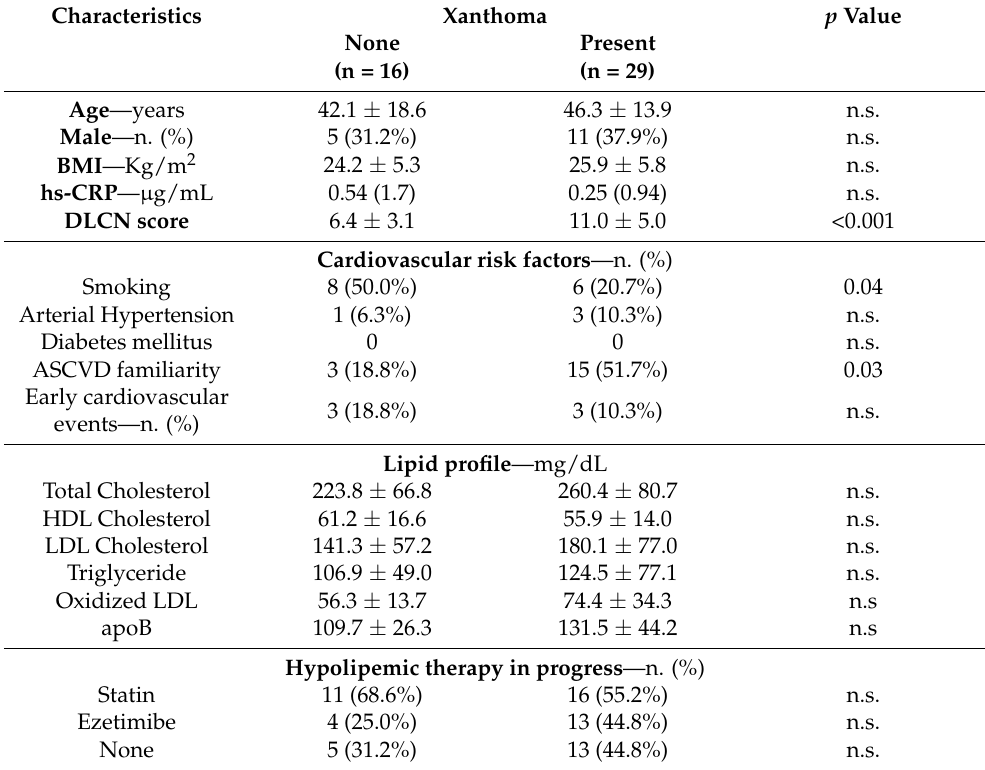
Table 1. General characteristics of the study